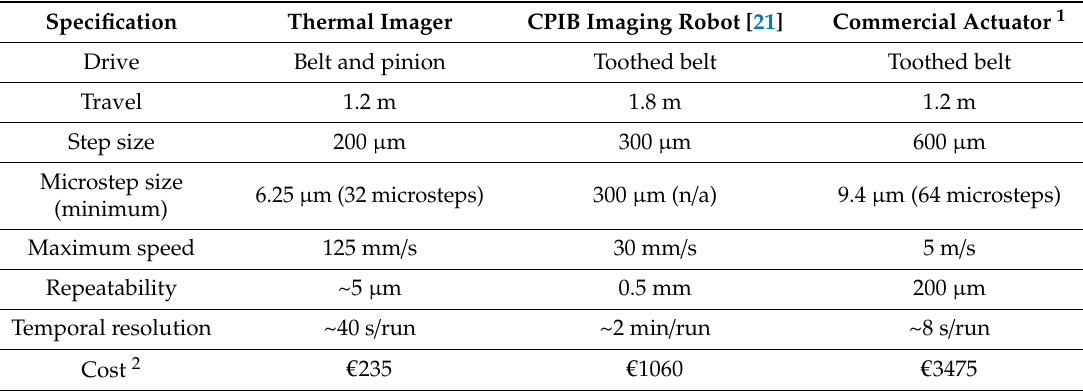
Table 2. Comparison of Thermal Imager specifications with competing (research and commercial) robots. Table2. ComparisonofThermalImagerspecificationswithcompeting(researchandcommercial)robots.